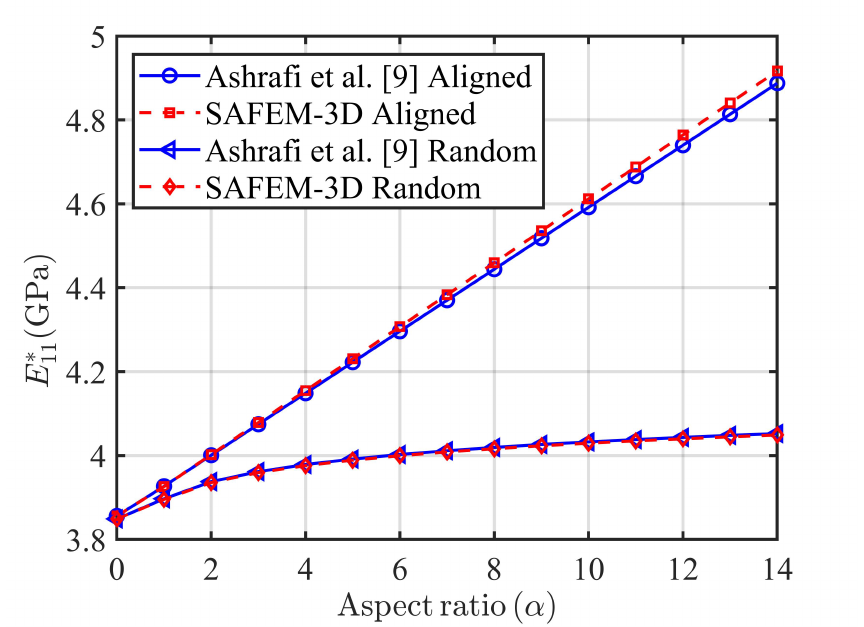
Figure 8. Longitudinal Young’s modulus for fibers in aligned and random configurations for a 1% SWNT/LaRC-SI